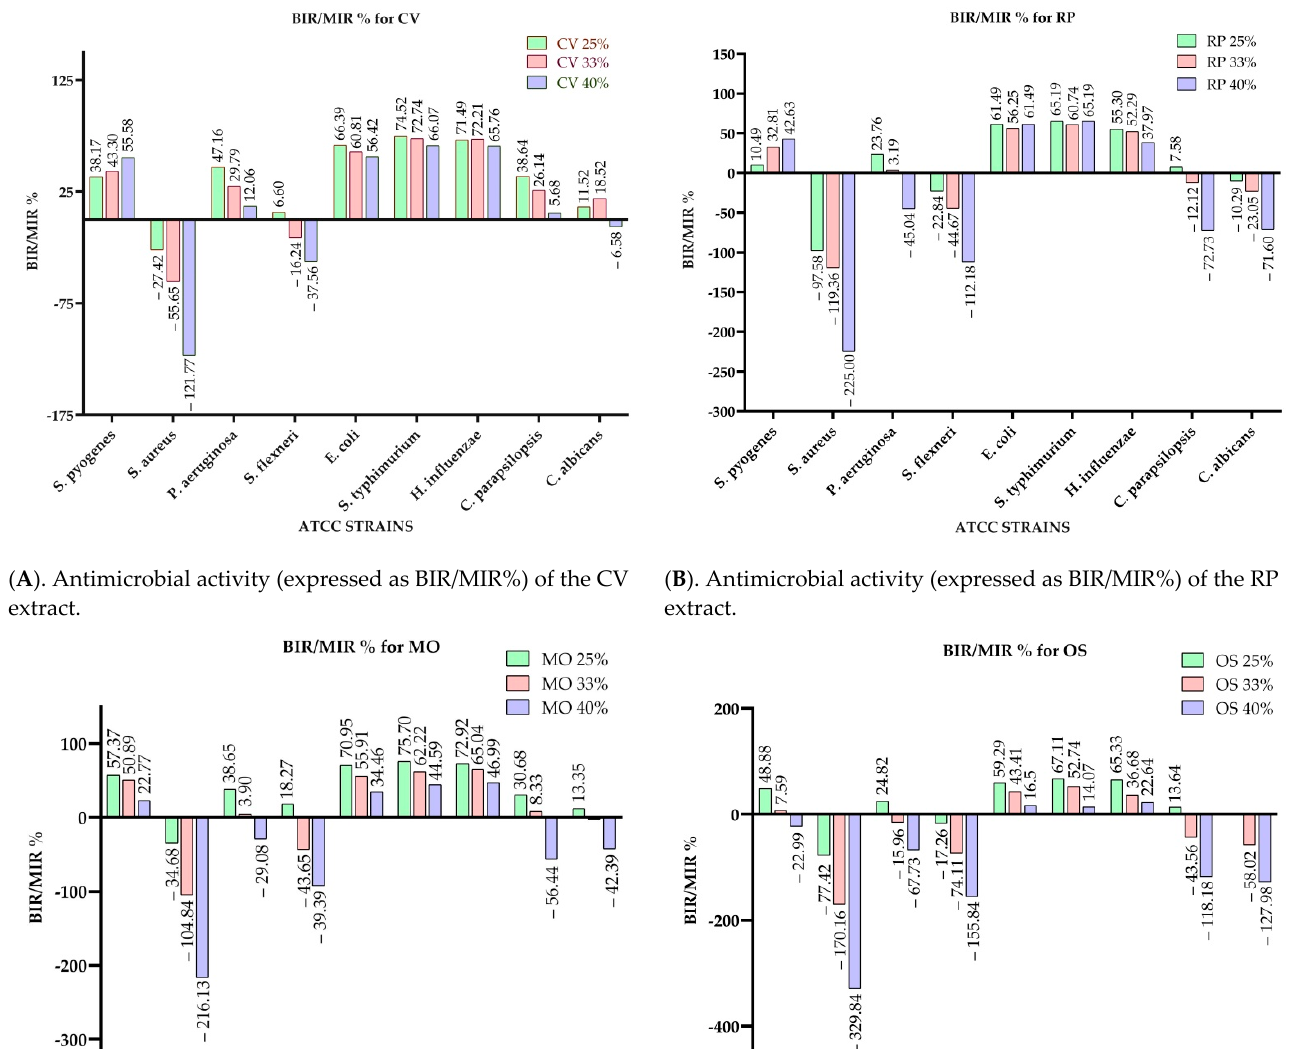
Figure 2. Antimicrobial activity of analyzed extracts expressed as BGR/MGR (%). ( A ). CV extract; ( B ). RP extract; ( C ). MO extract; ( D ). OS extract.